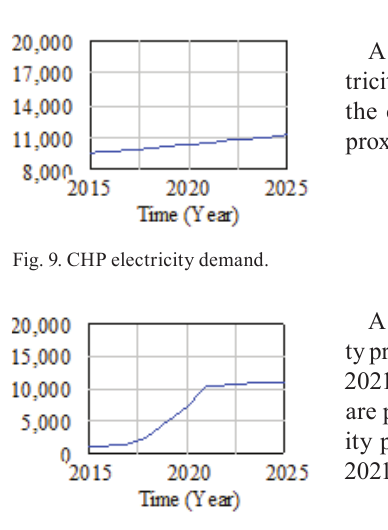
Fig. 10. CHP electricity